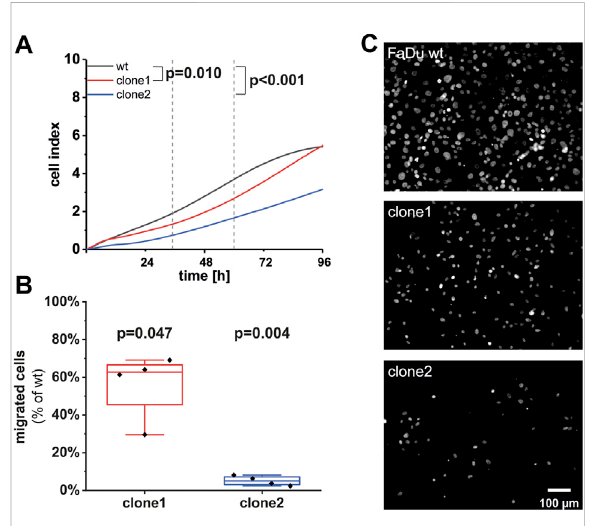
FIGURE 5 Effect of the SEC62 -knockout on the proliferative and migratory potential of newly generated FaDu cell clones. (A) As an indicator for cell proliferation in real-time the unitless cell index of FaDu wt (black line), clone 1 (red line) and clone 2 (blue line) was measured for 96 h. Shown is the mean of measured cell indices( n =12). Eachexperimentwasperformedinquadruplicates for each cell population. The slope of each cell line was calculated within a time range of 35 h up to 60 h after cell seeding. The proliferation rates of clone 1 ( p = 0.0095) as well as clone 2 ( p = 3.34e-4) were signi fi cantly reduced compared to the wt cells. (B) Cells were allowed to migrate through 8 µm pores of the insert system for 72 h. Each experiment was performed in technical duplicates, biological replicates were done 4 times. For quanti fi cation 3 different areas per insert were analyzed. Shown is the percentage of migrated cells of both clones in comparison to wt cells. The line within the box indicates the median. (C) Representative images of migrated cells of different cell populations. Scale bar: 100 μ m wt, wild